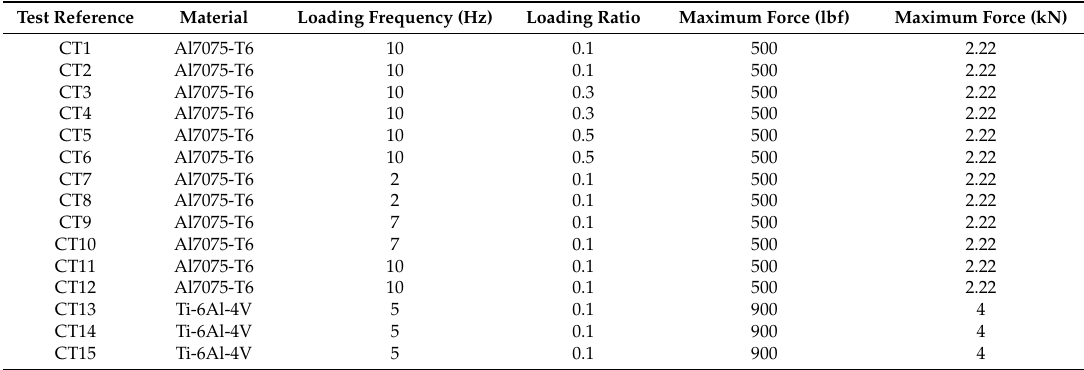
Table 1. Details of experiments and load parameters.